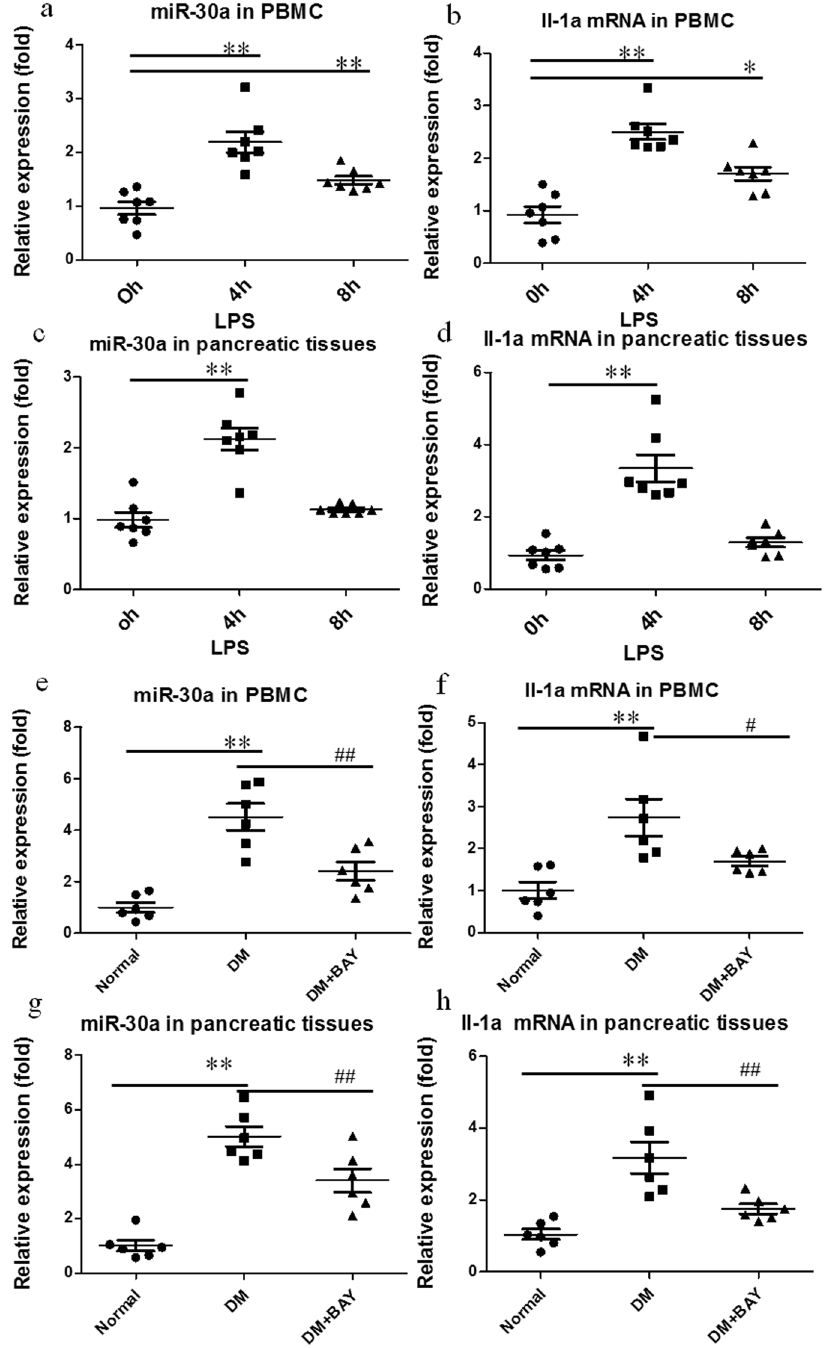
Figure 8. Endogenous miR-30a and Il-1a mRNA expression levels in PBMC and pancreatic tissues in LPS- and STZ-induced mice assayed by RT-PCR. ( a – d ) Endogenous miR-30a and Il-1a mRNA expression levels showing a transient increase in PBMCs and pancreatic tissues from LPS (2 mg/kg, ip)-induced mice within 8 h; ( e , f ) endogenous miR-30a and Il-1a mRNA expression levels showing a significant increase in PBMCs and pancreatic tissues of STZ (100 mg/kg, ip)-induced mice after 4 weeks, but this increase was significantly attenuated by BAY117082 (5 mg/kg, ip), an NFKB inhibitor. Normal, normal control mice; DM, diabetic control mice; and DM + BAY, diabetic mice treated by BAY117082. Data are expressed as the Mean ± SD (n = 6–7); for LPS induced mice, ** P < 0.01 for mice after LPS treatment (4 h or 8 h) vs. controls before LPS treatment (0 h) (see 8a–d). For STZ-induced diabetic mice, ** P < 0.01 for diabetic control mice vs. normal control mice, and # P < 0.05 and ## P < 0.01 for diabetic mice treated by BAY117802 vs. diabetic control mice (see